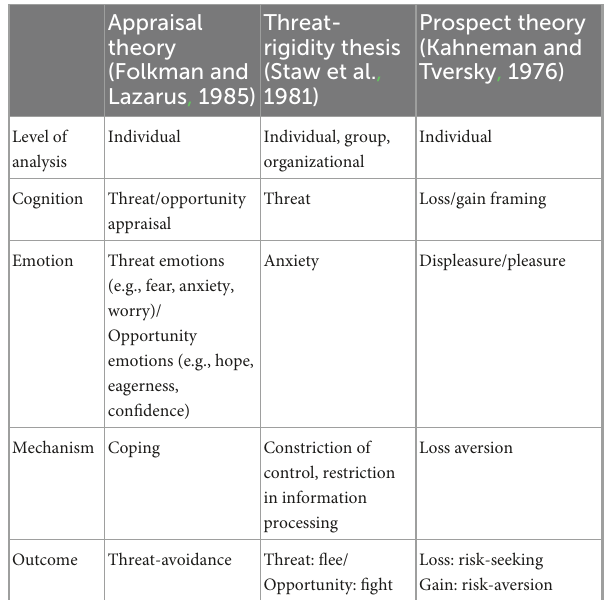
TABLE 1 Summary/comparison of appraisal theory, threat rigidity, and prospect